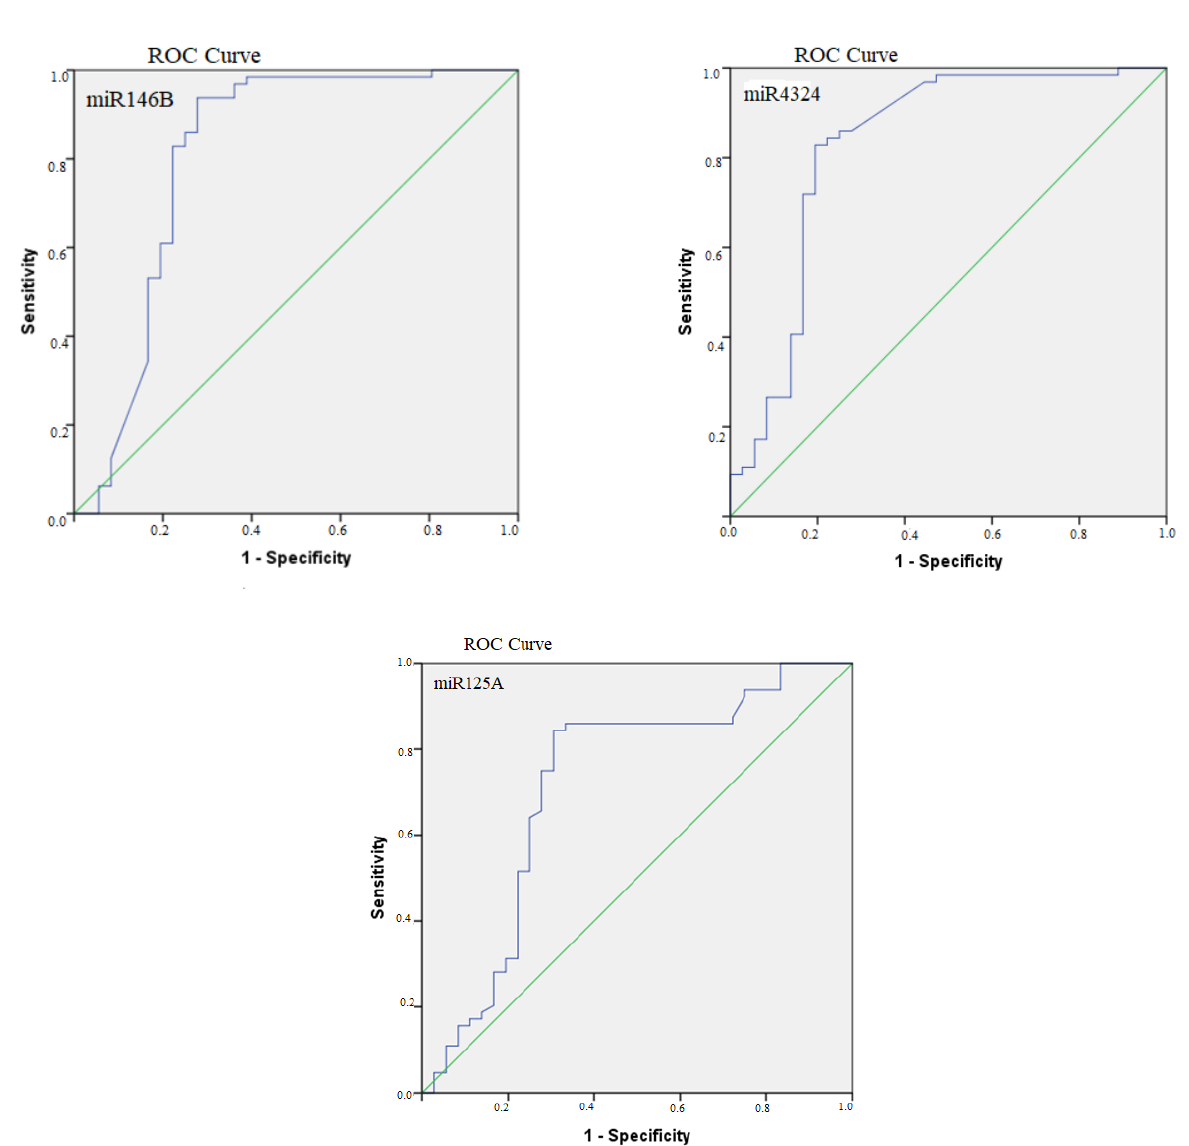
Figure 3. Prognostic value of miRNA in differentiating malignant from benign thyroid nodules. ROC (receiver operating characteristic) curves were used to distinguish the groups.